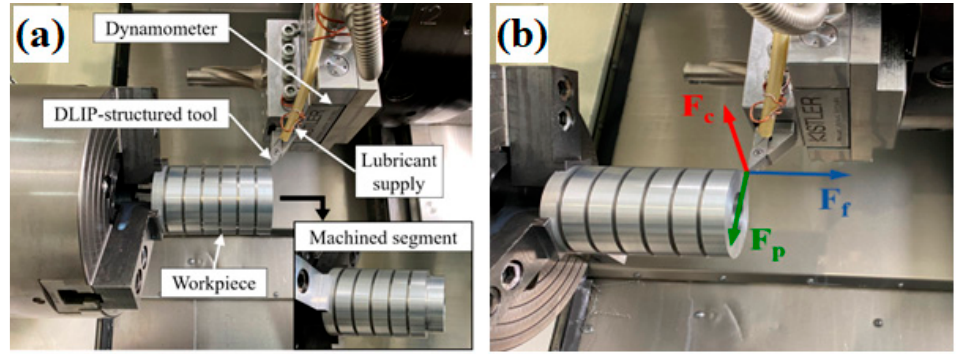
Figure 2. ( a ) Experimental design: Universal CNC lathe (type CTX alpha 300), dynamometer (type 9129AA) mounted on the tool holder, the cylindrical workpiece (Al 6061T6) preprocessed in defined segments; ( b ) Overview and direction of process forces (F c —cutting force, F f —feed force, F p —passive force) .